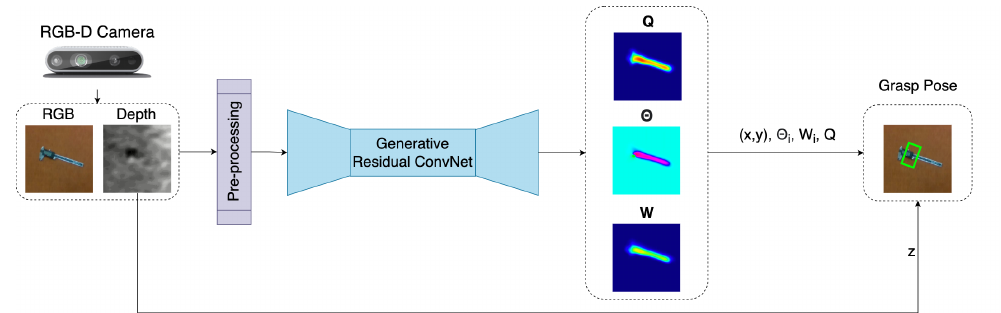
Figure 3. Inference module predicts suitable grasp poses for the objects in the camera’s field of